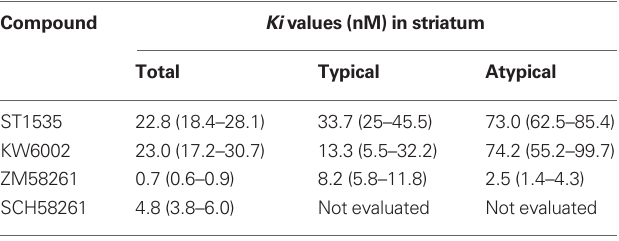
Table 1 | Displacement of [ 3 H]CGS 21680 binding from total, typical and atypical adenosine A receptors in rat striatal membranes. 2A